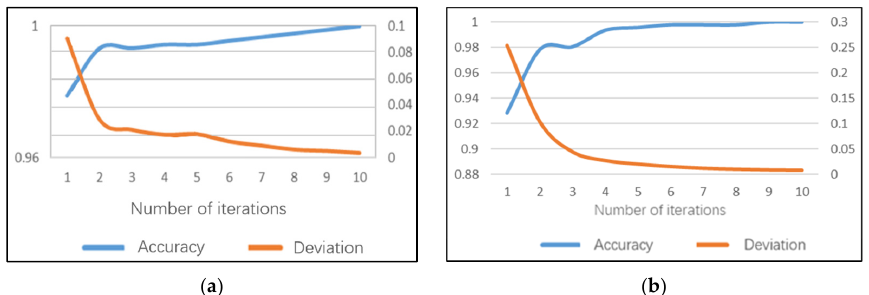
Figure 11. Training performance of not looking ahead sub-model: ( a ) daytime; ( b ) night.